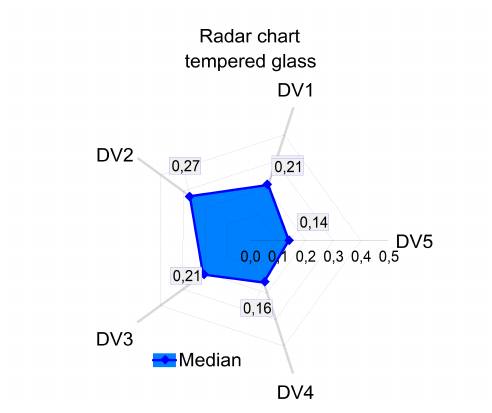
Figure 4: Radar chart for tempered glass. A 4 =